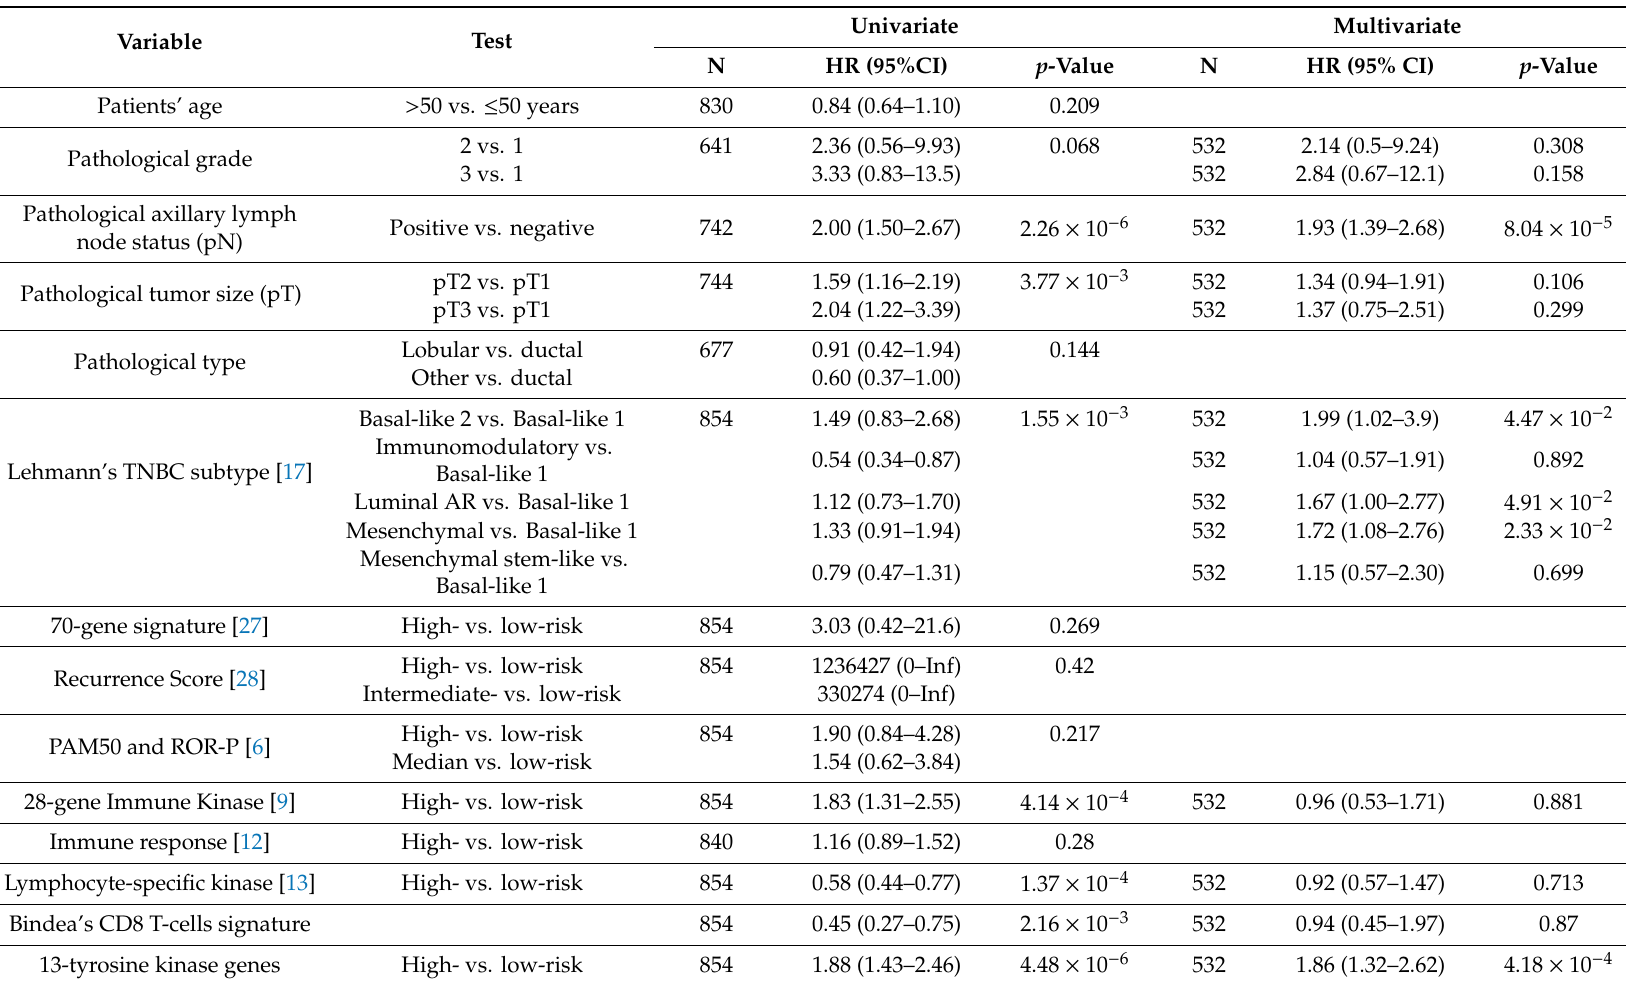
Table 4. Uni- and multivariate prognostic analyses for